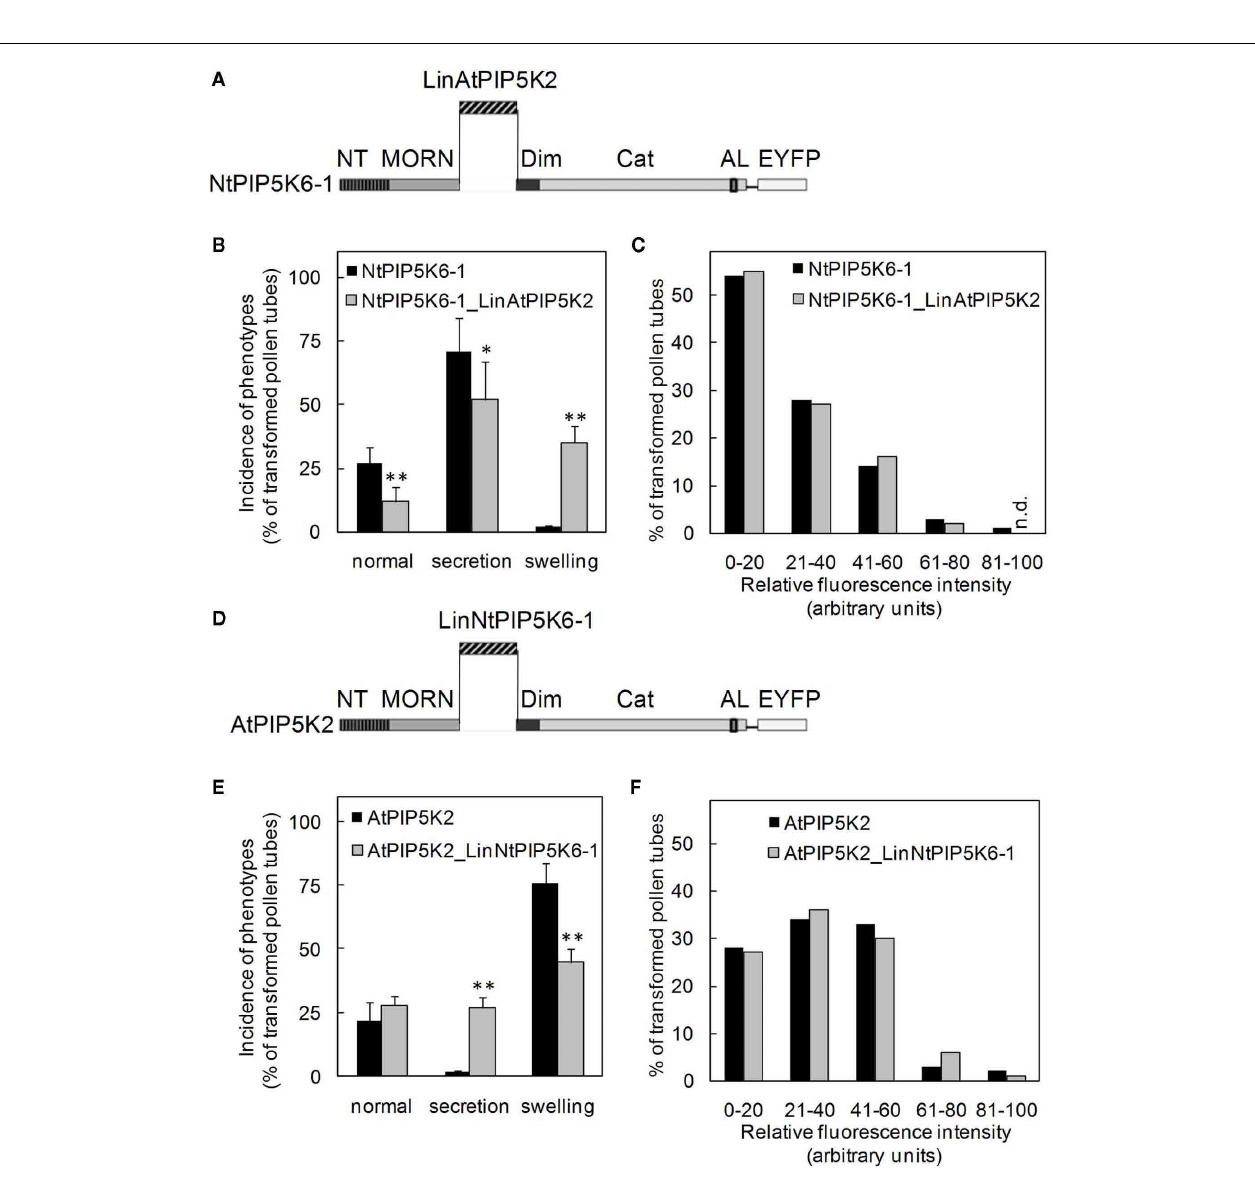
Fluorescence intensity distribution corresponding to overexpression of NtPIP5K6-1 (black bars) or NtPIP5K6-1_LinAtPIP5K2 (gray bars) shown in (B) . (D) , Graphical representation of the chimeric fusion protein AtPIP5K2_LinNtPIP5K6-1; (E) , Incidence of phenotypic categories observed upon overexpression of AtPIP5K2 (black bars) or AtPIP5K2_LinNtPIP5K6-1 (gray bars); (F) , Fluorescence intensity distribution corresponding to overexpression of AtPIP5K2 (black bars) or AtPIP5K2_LinNtPIP5K6-1 (gray bars) shown in (E) . Data are means ± SD from four independent transformation experiments and represent ≥ 300 transgenic pollen tubes observed for each construct. n.d., Not detected.The asterisks indicate a significant difference from the full-length control within each category according to a Student’s t test (* p < 0.05; ** p < 0.01).